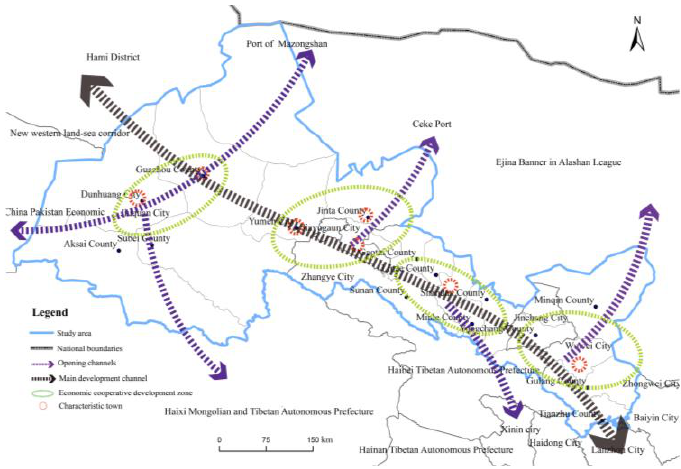
Figure 10. Spatial collaborative and integrated development model of the Hexi Corridor urban ag-